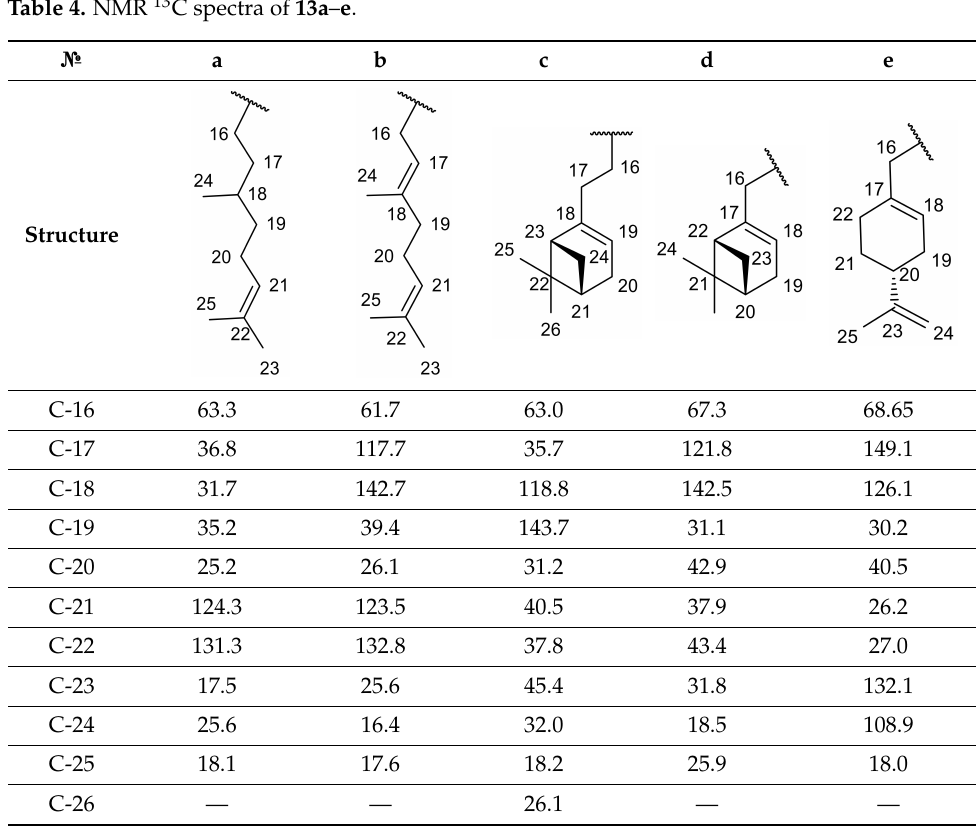
Figure 5. Structures of compounds 13a-e with atom numeration. Table 4. NMR 13 C spectra of 13a – e